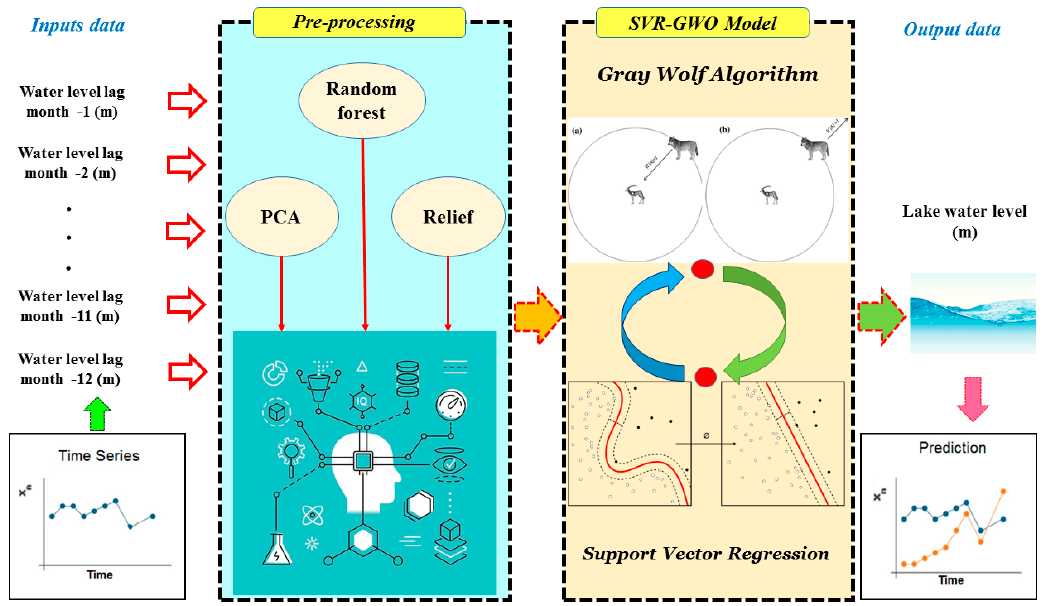
Figure 5. Schematic view of predicting lake water lake by SVR and SVR-GWO by using data-driven techniques.